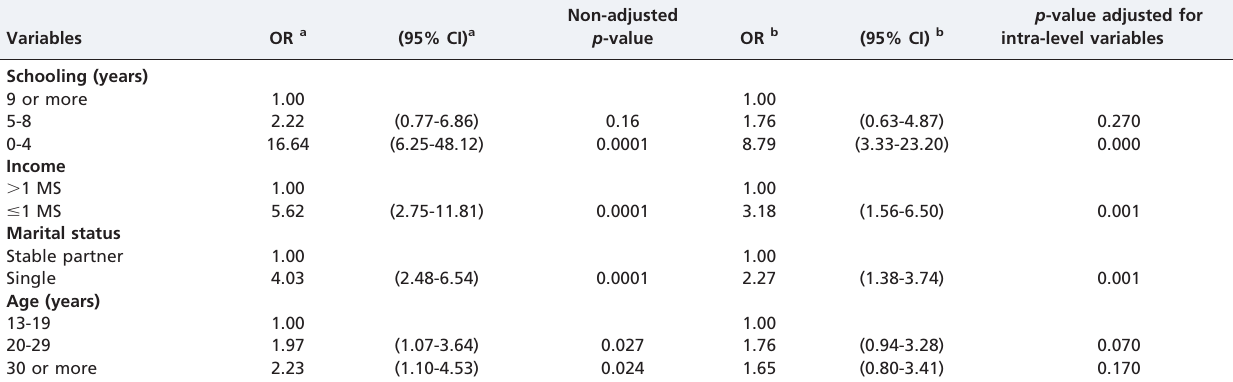
Table 2 - Multivariate analysis of the association between the socioeconomic-demographic variables and periodontitis in pregnant women from Recife, Brazil,